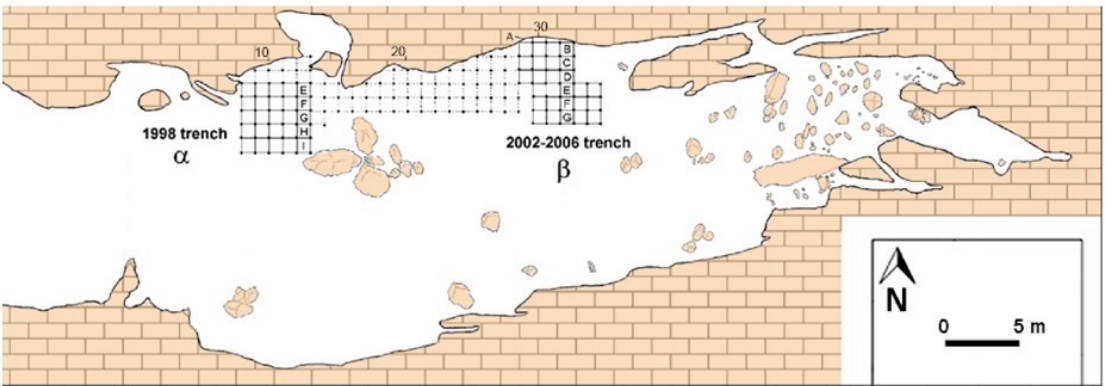
Figure 7. Plan of the San Teodoro Cave. Opening on the west (left side). The location of the α trench (squares E–I/9–13) excavated in 1998 and β trench (squares A–G/29–34) excavated in 2002–2006 is indicated (from [30], modified).